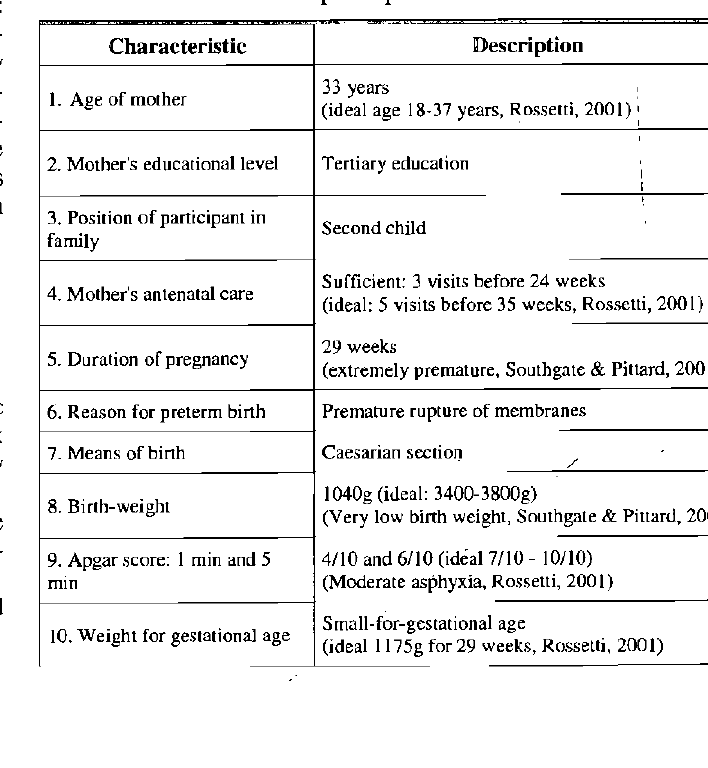
Table 1. Characteristics of participant at